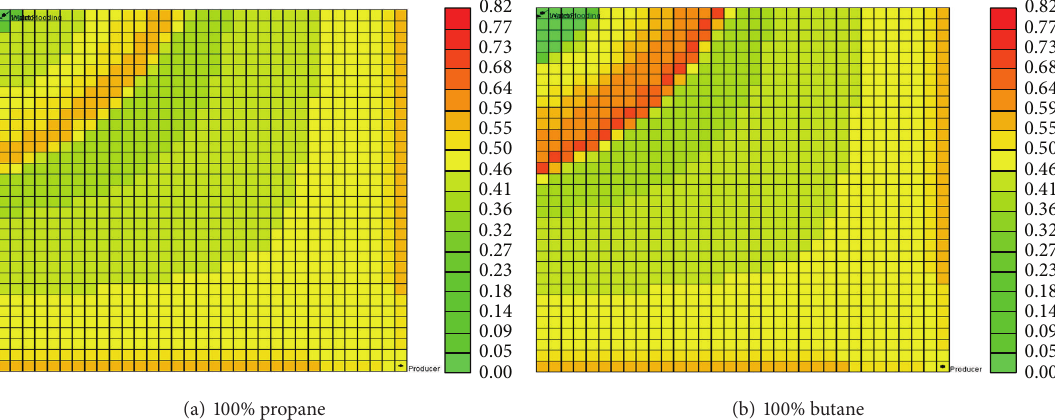
Figure 10: Oil saturation with LPG composition after six months of gas injection (LPG volume fraction of injection gas: